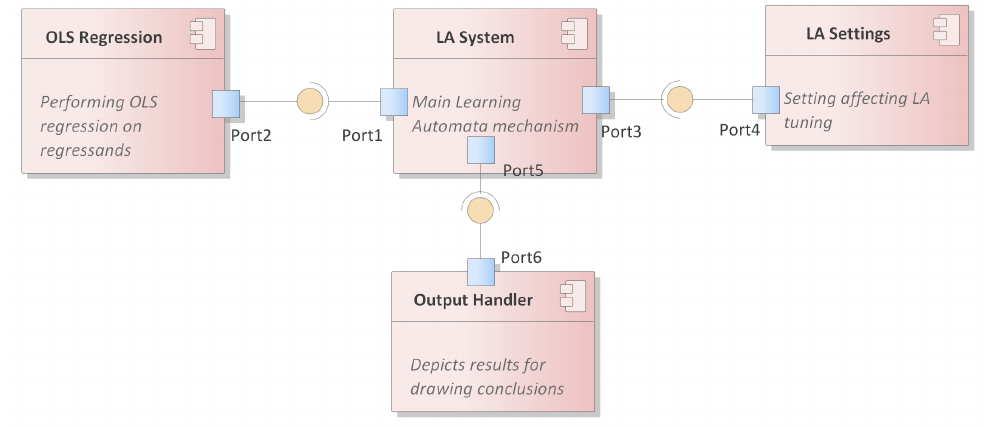
Figure 2. Orion component